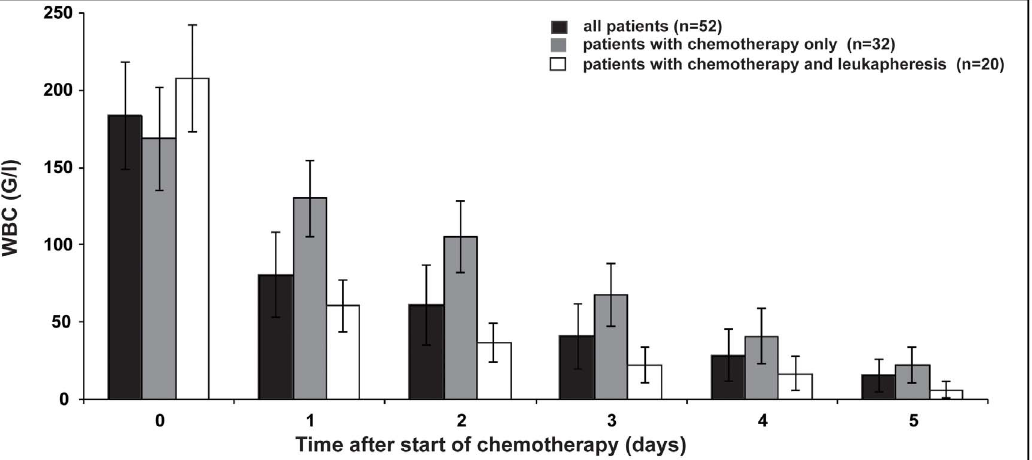
Figure 3. Efficacy of reduction of WBC with chemotherapy only and chemotherapy combined with leukapheresis. Abbreviations: WBC, white blood count.